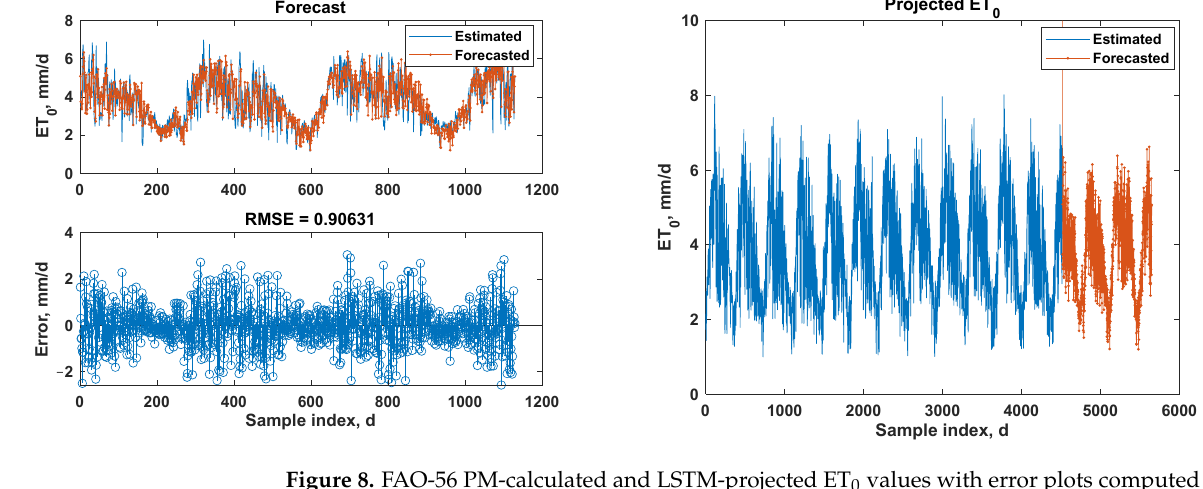
Figure 8. FAO-56 PM-calculated and LSTM-projected ET 0 values with error plots computed on the test dataset.